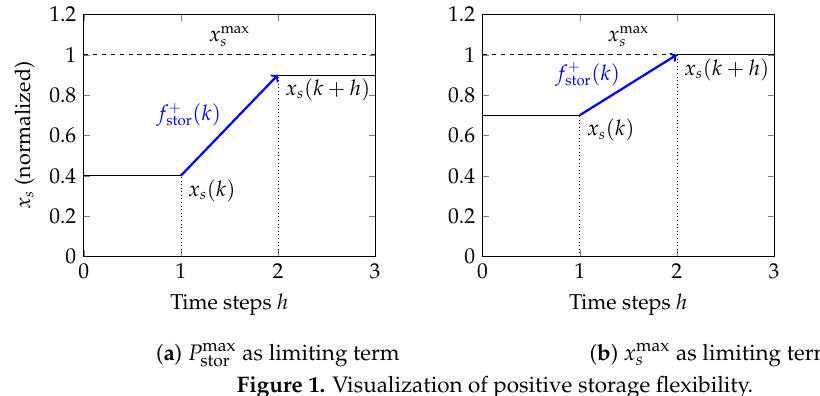
Figure 1. Visualization of positive storage